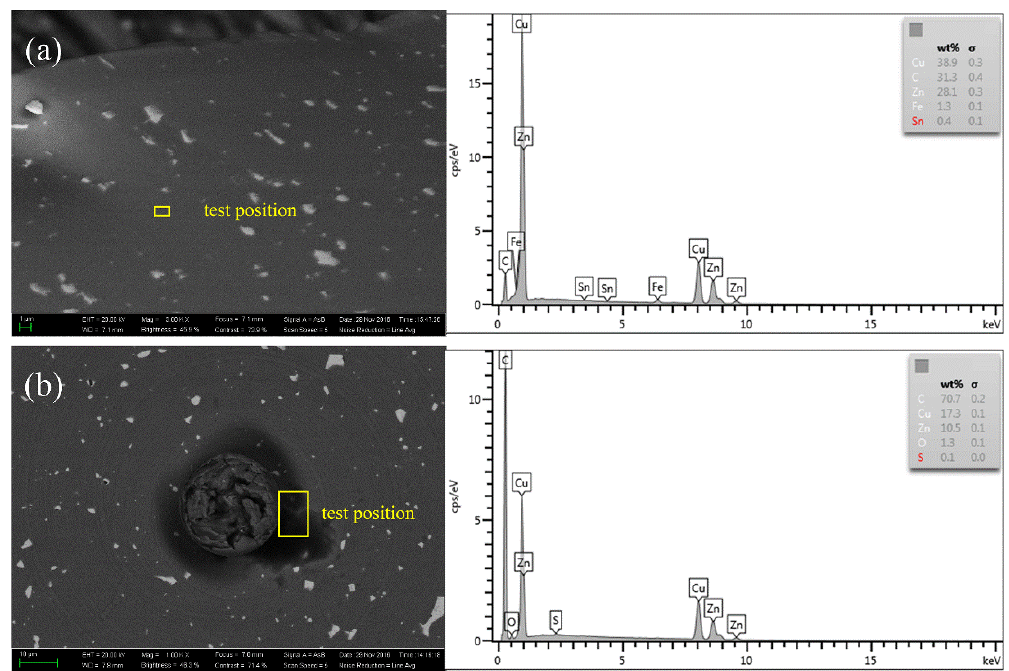
Figure 15. Backscattering scanning electron microscopy (BSEM) image and the EDS results of the cutting chip ( a ) and the workpiece center ( b ), where the extra carbon element is detected in the two positions.